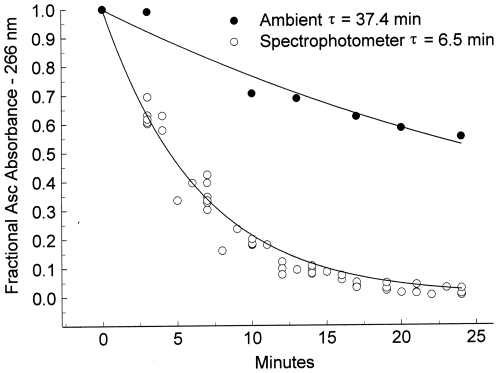
Quantitation of ambient (room) and spectrophotometer (UV light exposed) oxidation of ascorbate.Each symbol represents the average absorbance at 266 nm of 3 wells to which ascorbate is added. The additions were temporally sequential, with both the new additions and those from previous additions measured separately at each subsequent time. The solid symbols, determined by the first measurement after the addition from a room stock, show the ambient Asc oxidation. The open symbols show the Asc oxidation of the seven sets of three wells within the spectrophotometer, with the data normalized to the initial absorbance of that sample when first measured in the spectrophotometer. The lines were calculated from a linearized least squares fit of the data with an absorbance of 0.3 or greater of the initial absorbance.